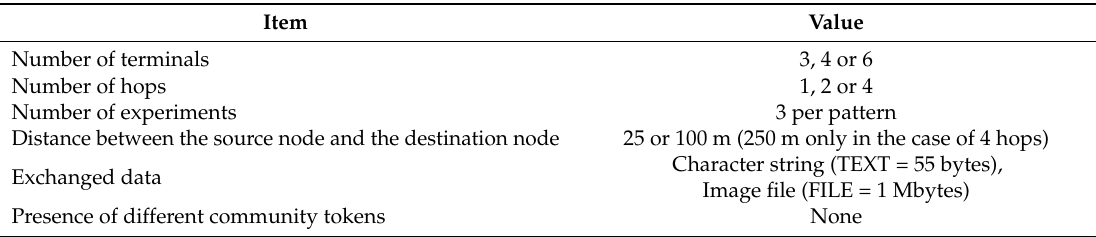
Table 11. Experimental conditions for measuring data exchange